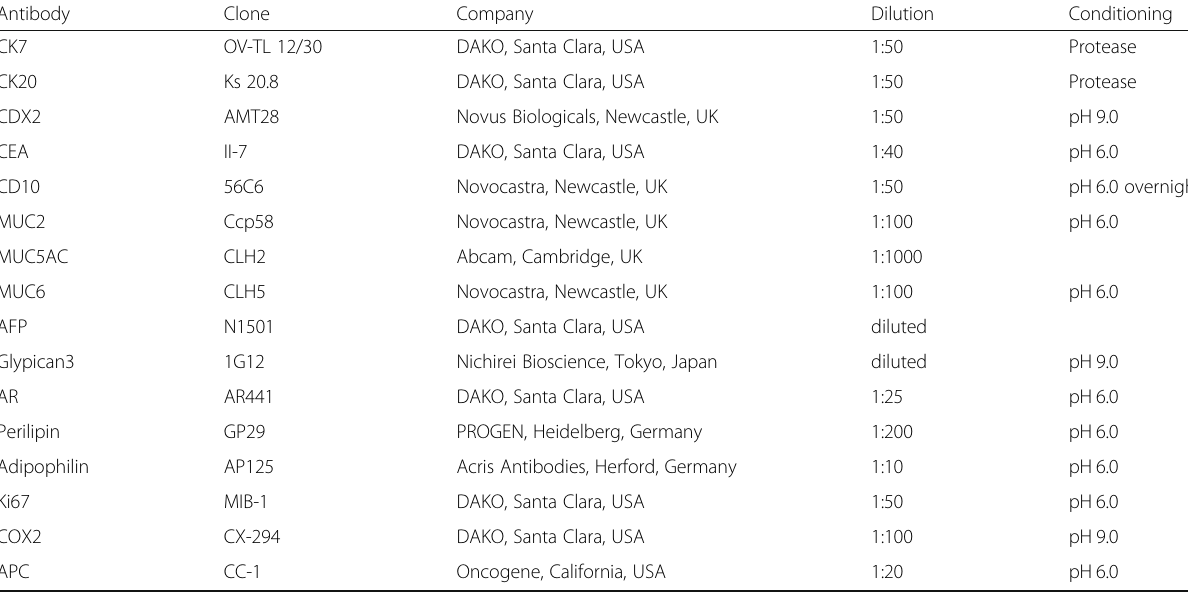
Table 1 Antibody information Antibody